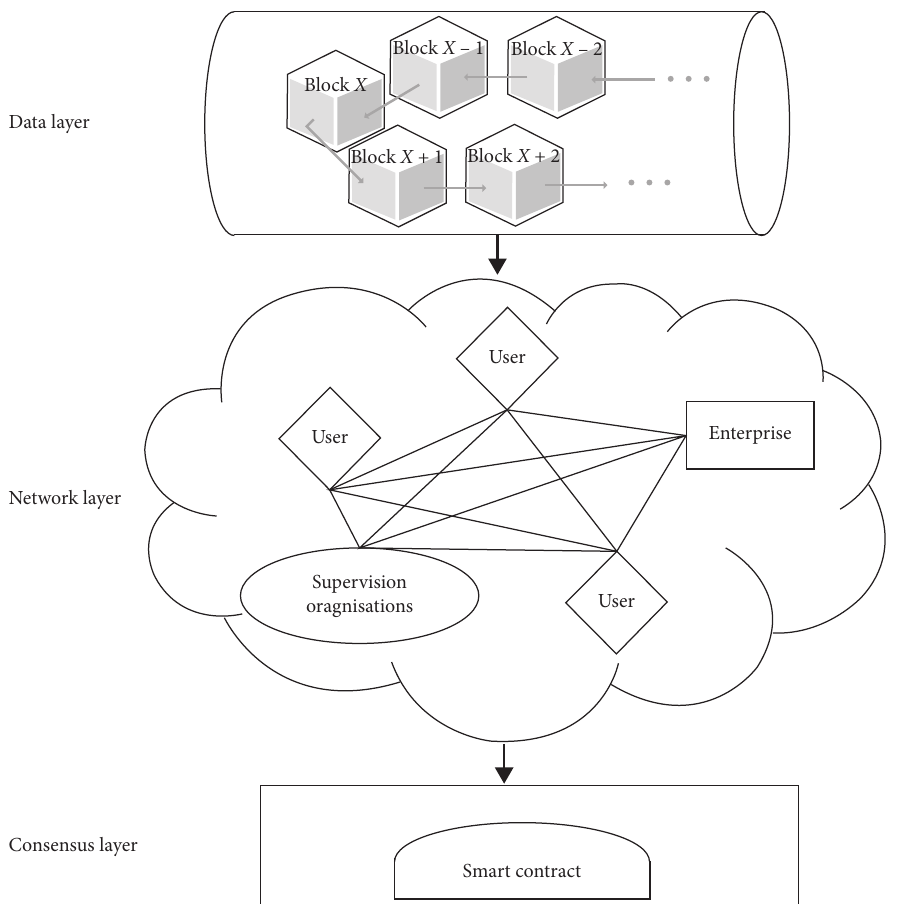
Figure 1: Blockchain shared bicycle deposit management